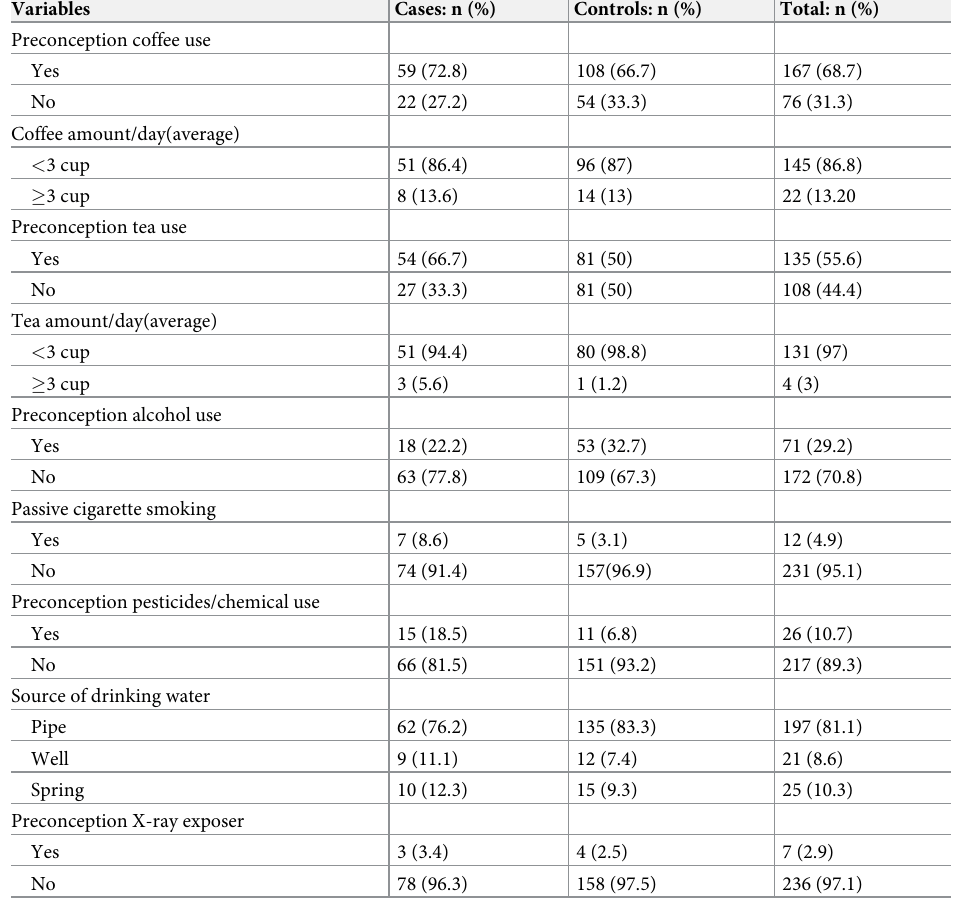
Table 4. Behavioral and environmental characteristics of mothers who gave birth in North Shoa Zone Hospitals, Amhara Region, Ethiopia, 2020.